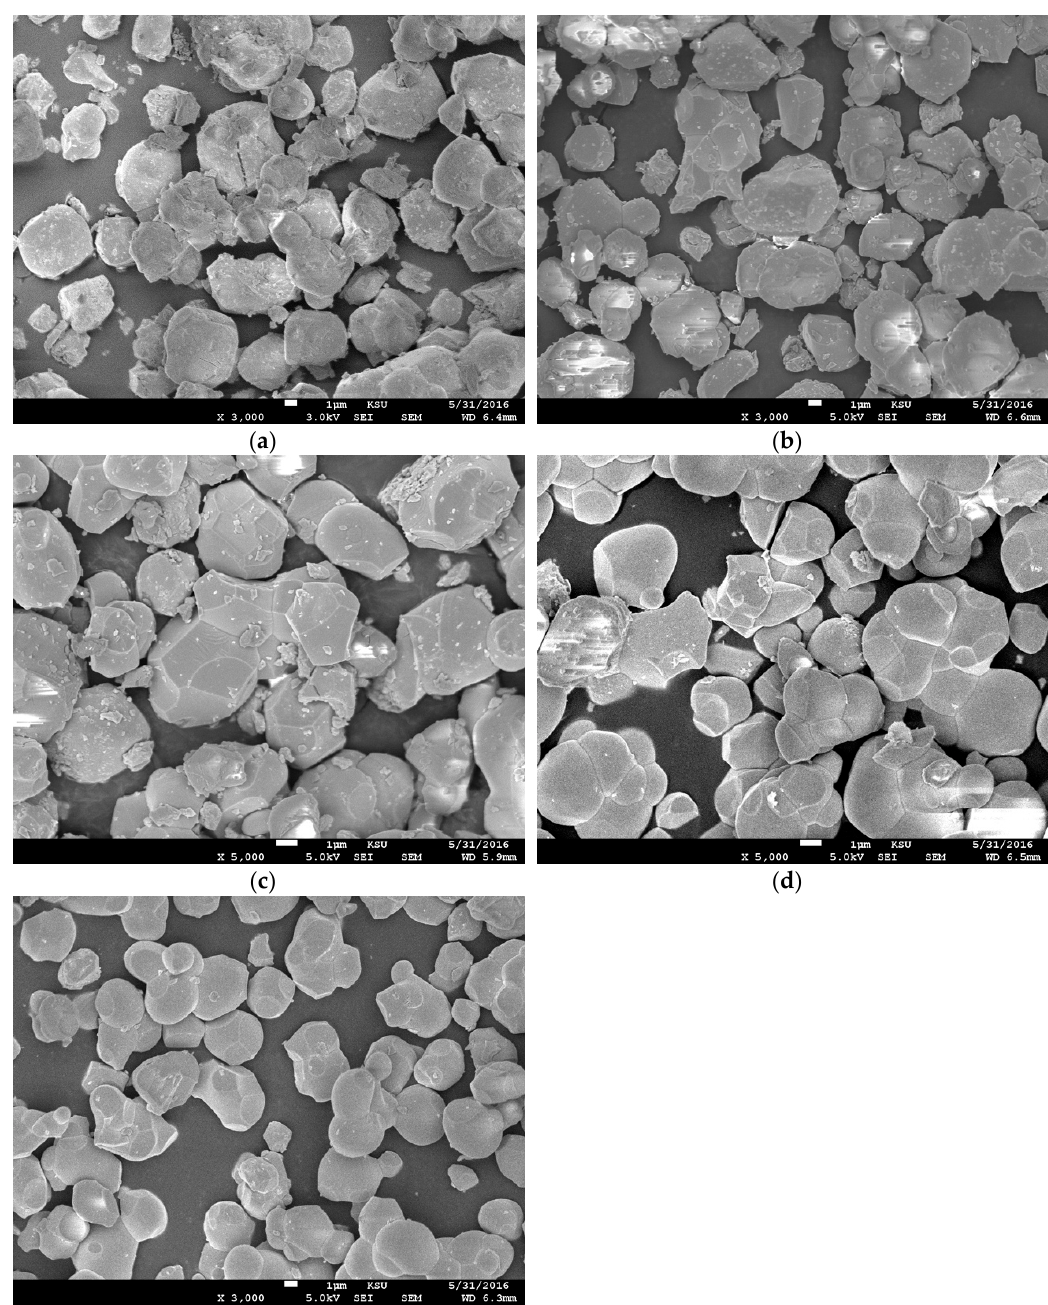
Figure4. ( a – e )SEMimagesofBa 2 − x Sr x ZnWO 6 (x = 1, 1.25, 1.50, 1.75,